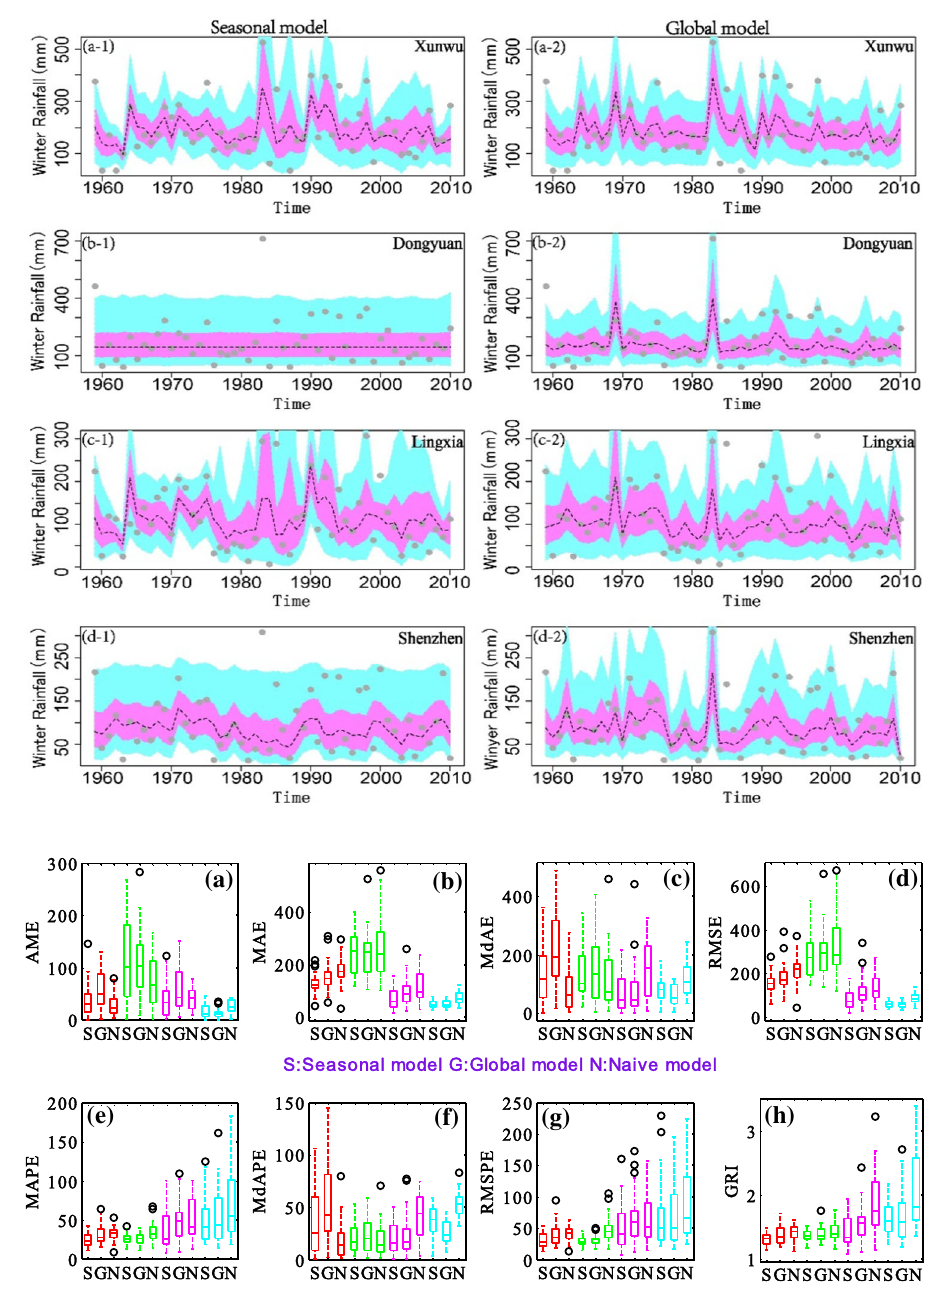
accuracy indices for the track predictions of seasonal precipitation (from left to right: spring, summer, autumn, and winter) during 2006–2010, using the seasonal, global, and naı¨ve models in the track precipitation forecasting practice for all 29 stations in the East River basin of southeastern